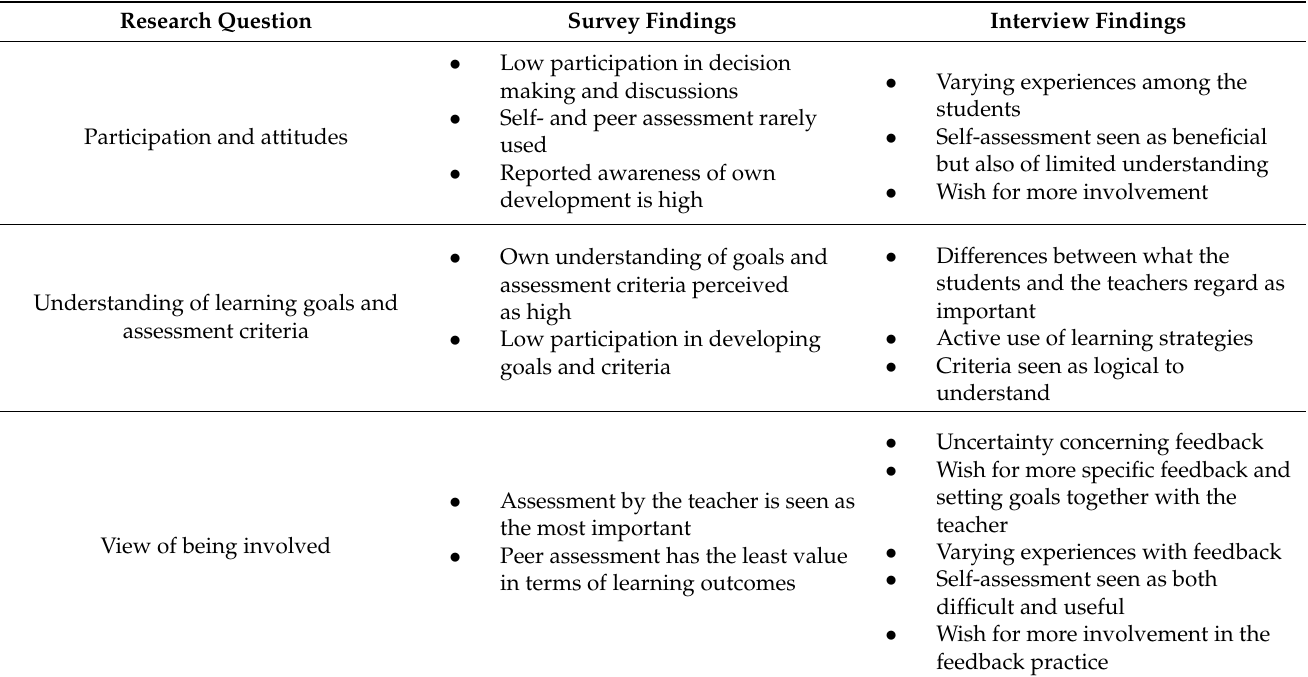
Table 2. Main findings from the surveys and interviews.